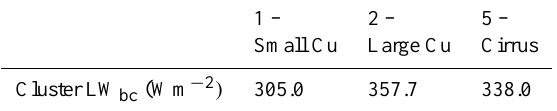
Table 6. Below-cloud upwelling LW